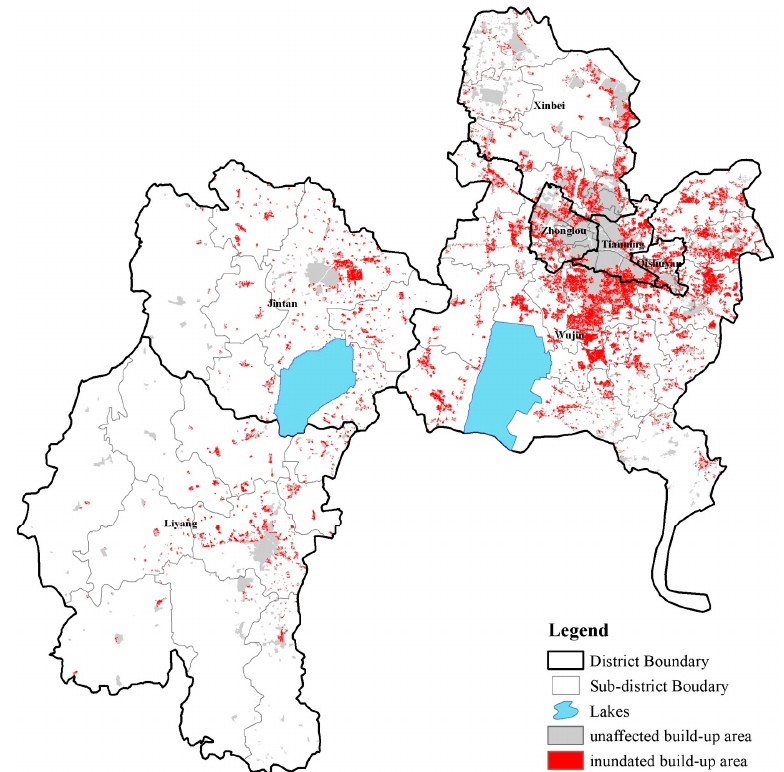
Figure A1. Inundated build-up area.